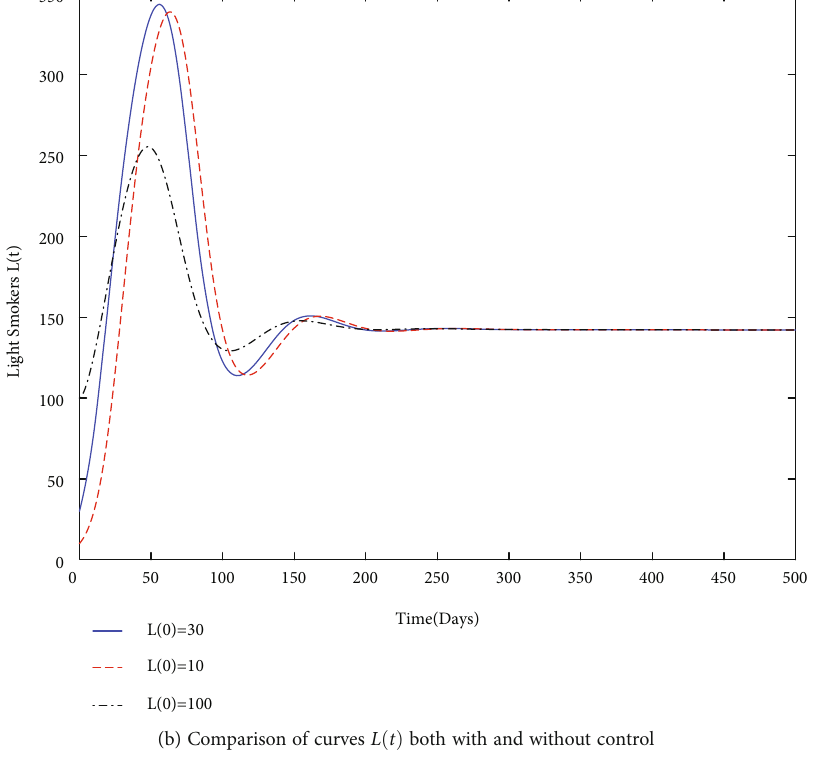
(a) The plot shows the overall e ff ect of control variables on the class of potential smokers